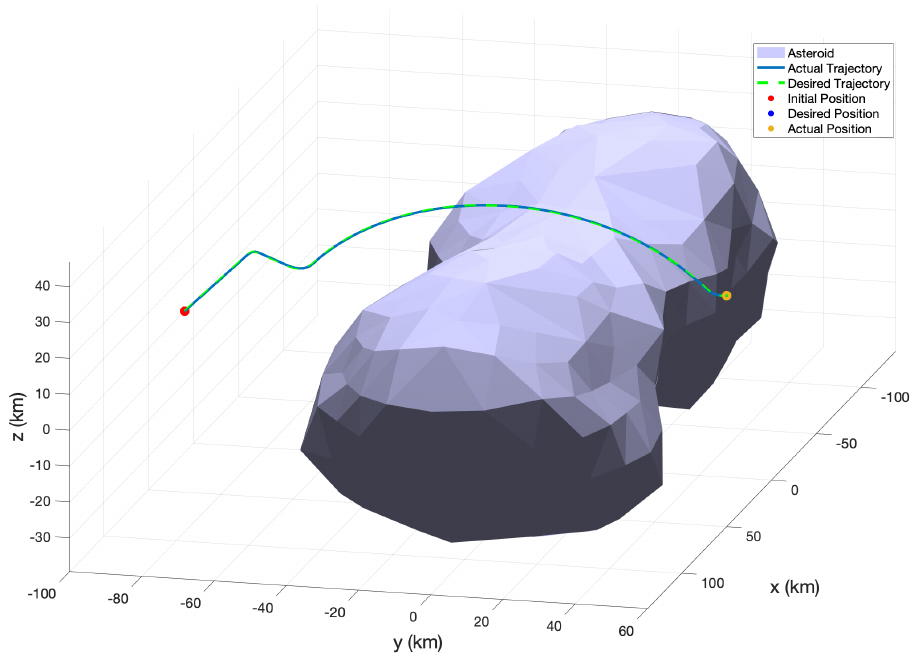
Figure 8. Trajectory of spacecraft around the asteroid Kleopatra for the adaptive control case.